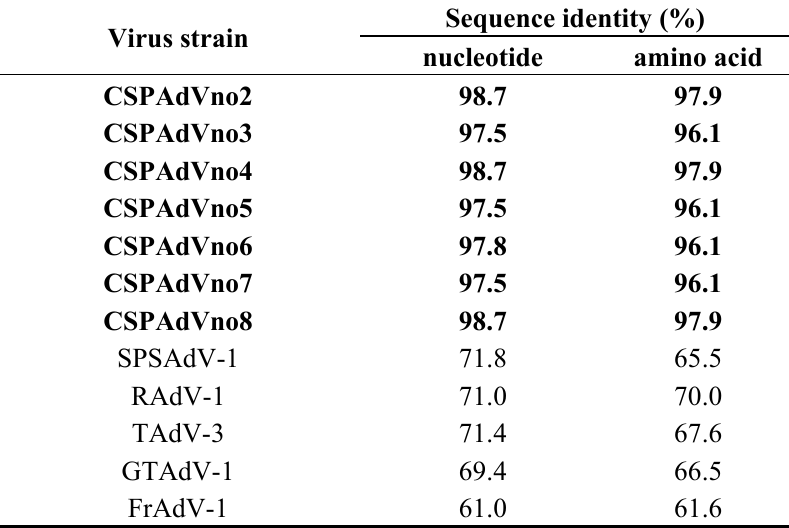
Table 2. Nucleotide and amino acid sequence identity (%) between CSPAdVno1 and other CSPAdV-1 strains and representative Siadenoviruses